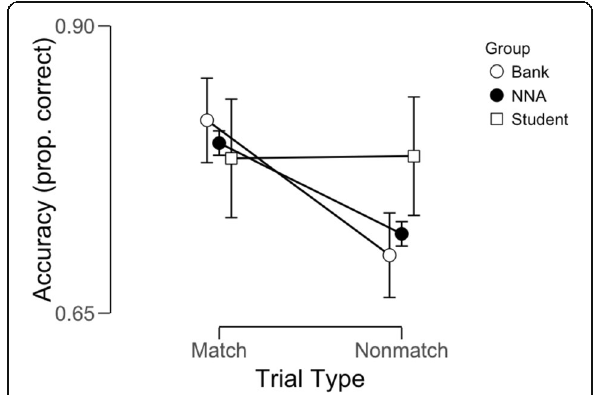
Fig. 2 Accuracy on match and nonmatch trials across separate groups.